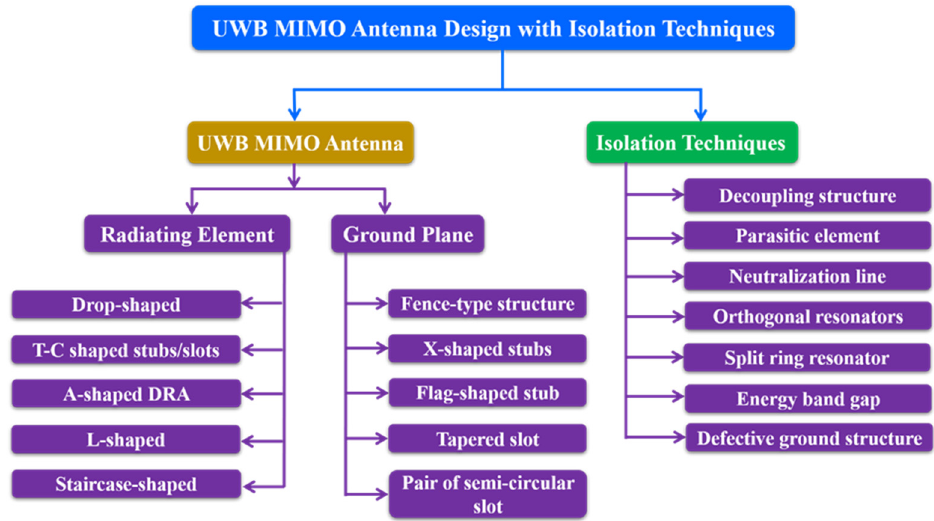
Figure 2. Typical UWB MIMO antenna design approaches.